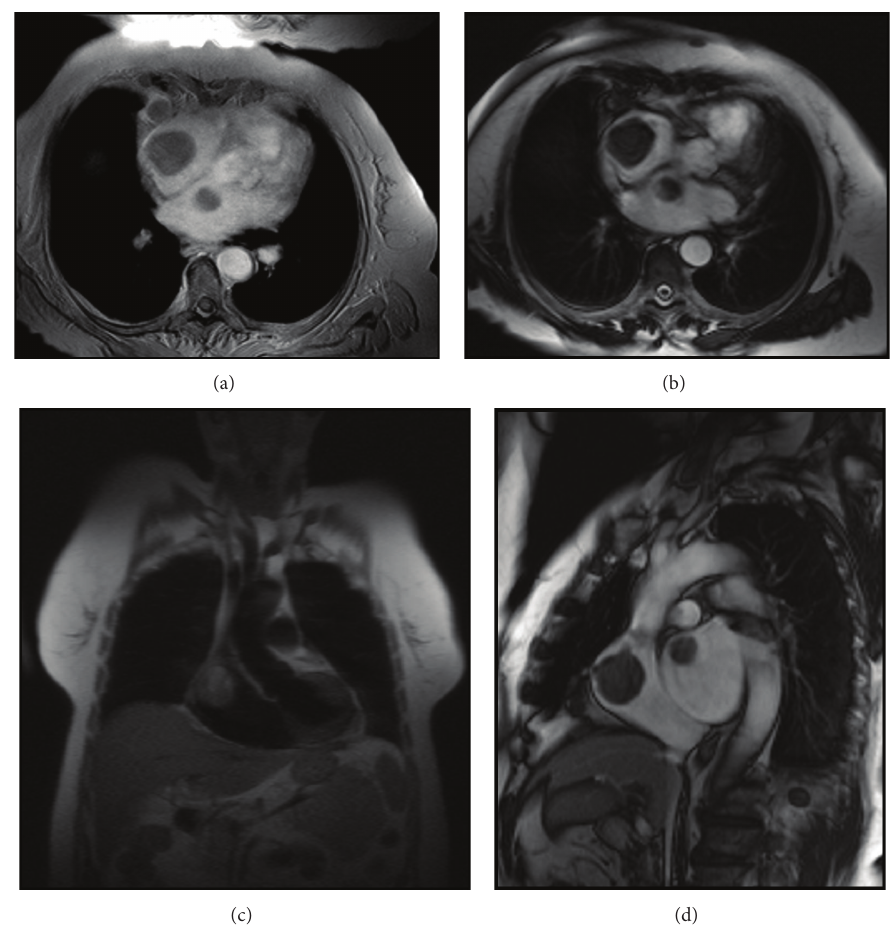
Figure 5: Cardiac MRI demonstrates two masses with biatrial cardiac metastases of malignant melanomas in uterine cervix: one is 37 mm and the other is 20 mm in right and left